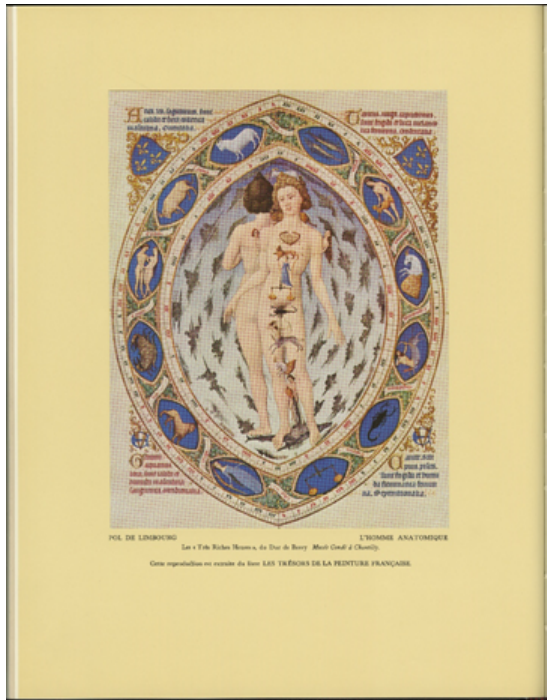
Fig. 9 Colour insert of the Limbourg brothers, Anatomical Zodiac Man (1411–16), in Minotaure , no. 6 (1935), no page. Photo: